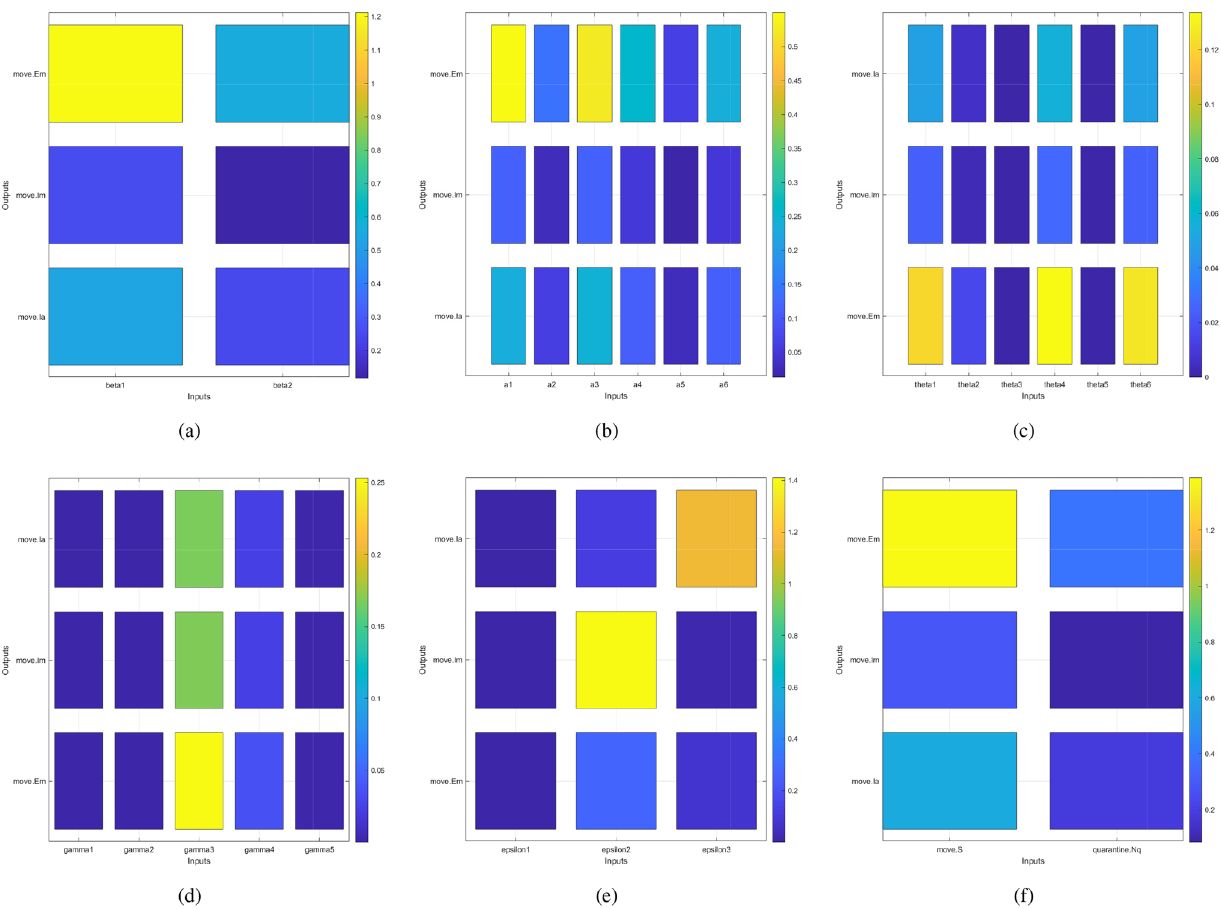
Figure 3. Global sensitivity analysis. Inputs: ( a ) transmission rate ( β 1 and β 2 ), ( b ) effective contact ratio ( a 1 – a 6 ), ( c ) transition rate [ θ 1 – θ 5 and θ 6 = ( 1 − θ 2 − θ 3 )], ( d ) recovery rate ( γ 1 – γ 5 ), ( e ) hospitalized rate ( ǫ 1 - ǫ 3 ), and ( f ) population size ( S and N q ). Output: exposed individuals with outside movement ( E m ), symptomatic infectious individuals ( I m ) and asymptomatic infectious individuals ( I a